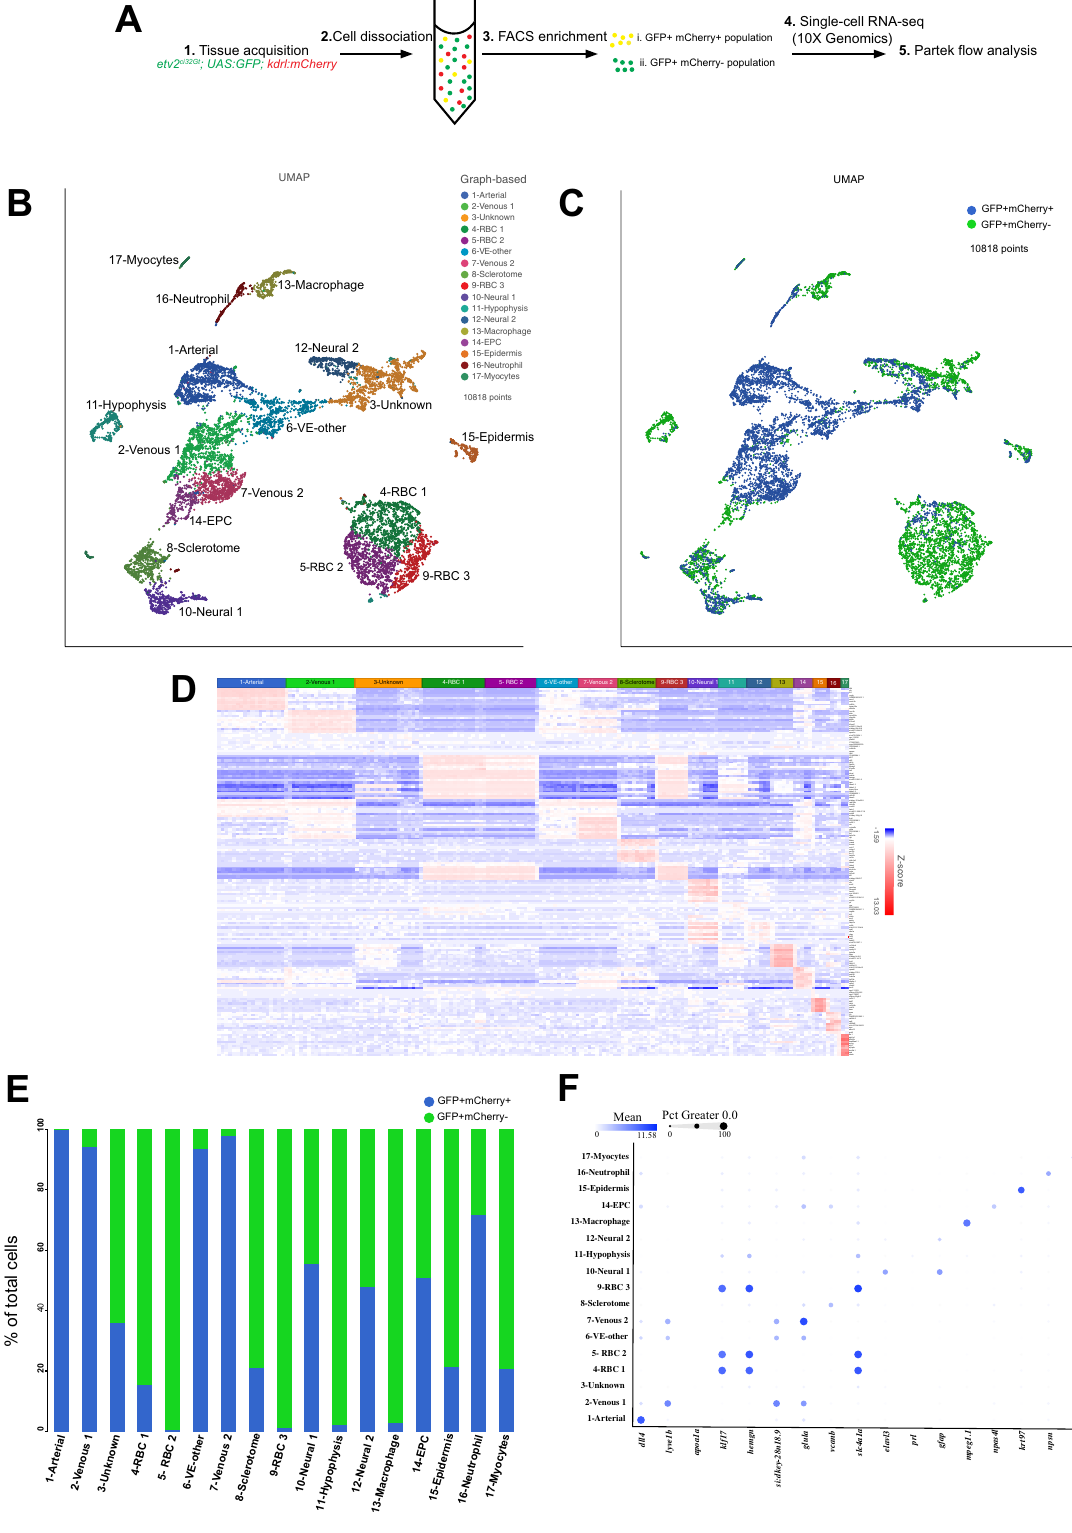
Figure 1. The scRNA-seq analysis of etv2 ci32Gt ; UAS:GFP ; kdrl:mCherry embryos at the 24 hpf stage. ( A ) Schematics of the experimental design for scRNA-seq. ( B ) UMAP plot of 10,818 cells with 17 distinct clusters. Classifications were based on previously known marker genes which were significantly enriched in each cluster. RBC, red blood cells; VE, vascular endothelial; EPC, endothelial progenitor cells. ( C ) UMAP plot showing the distribution of GFP + mCherry + and GFP + mCherry- cells. ( D ) A heatmap showing expression of top marker genes in different clusters. Enlarged heatmap and gene list is shown in Fig. S1. ( E ) Fraction of GFP + mCherry + and GFP + mCherry- cells within each cluster. ( F ) A dot plot showing the expression of selected marker genes in different